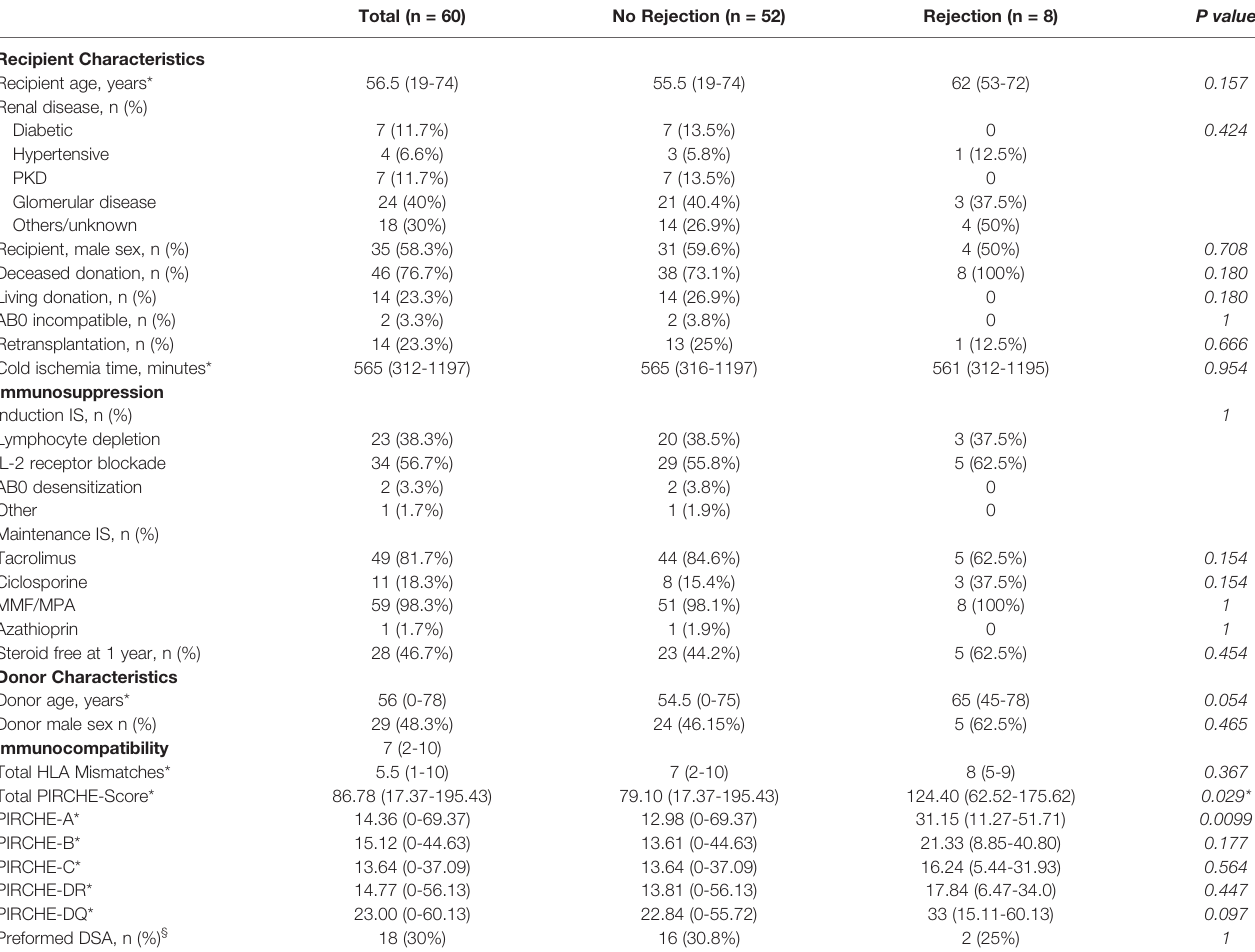
TABLE 1A | Clinical characteristics of KTRs with/without acute rejection in follow-up